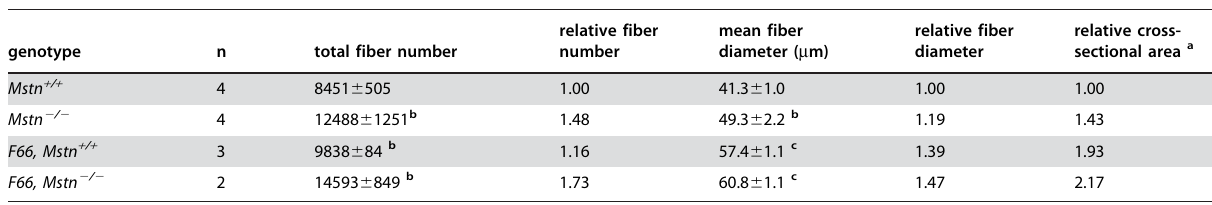
Table 2. Morphometric analysis of gastrocnemius/plantaris muscles. .. ... .... ... ... .... ... ... .... ... ... .... ... ... .... ... ... .... ... ... .... ... ... .... ... ... .... ... ... .... ... ... .... ... ... .... ... ... .... ... ... .... ... ... . genotype